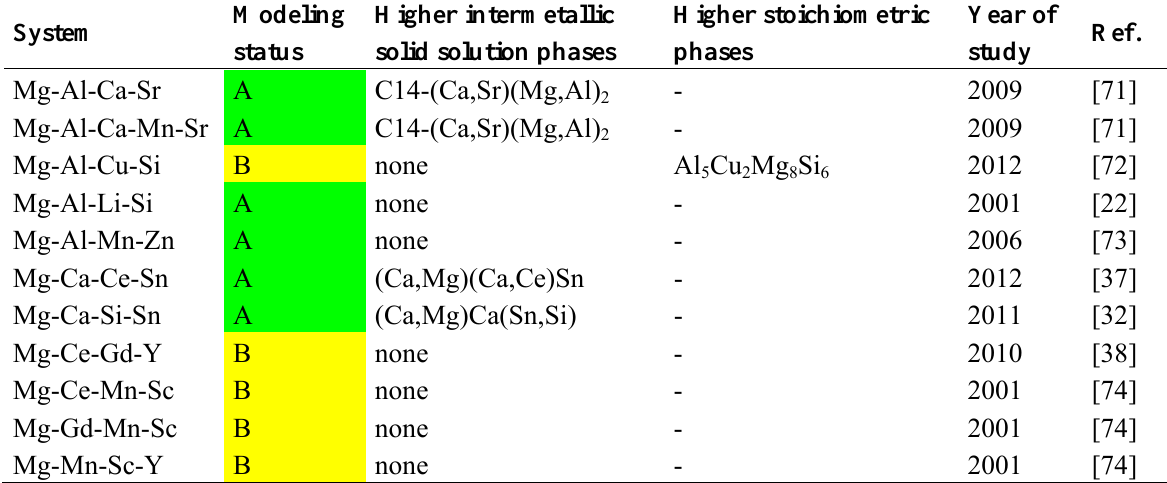
Table 4. Multicomponent Mg-containing systems with verified thermodynamic descriptions and their classified modeling status. Indication details same as in Table